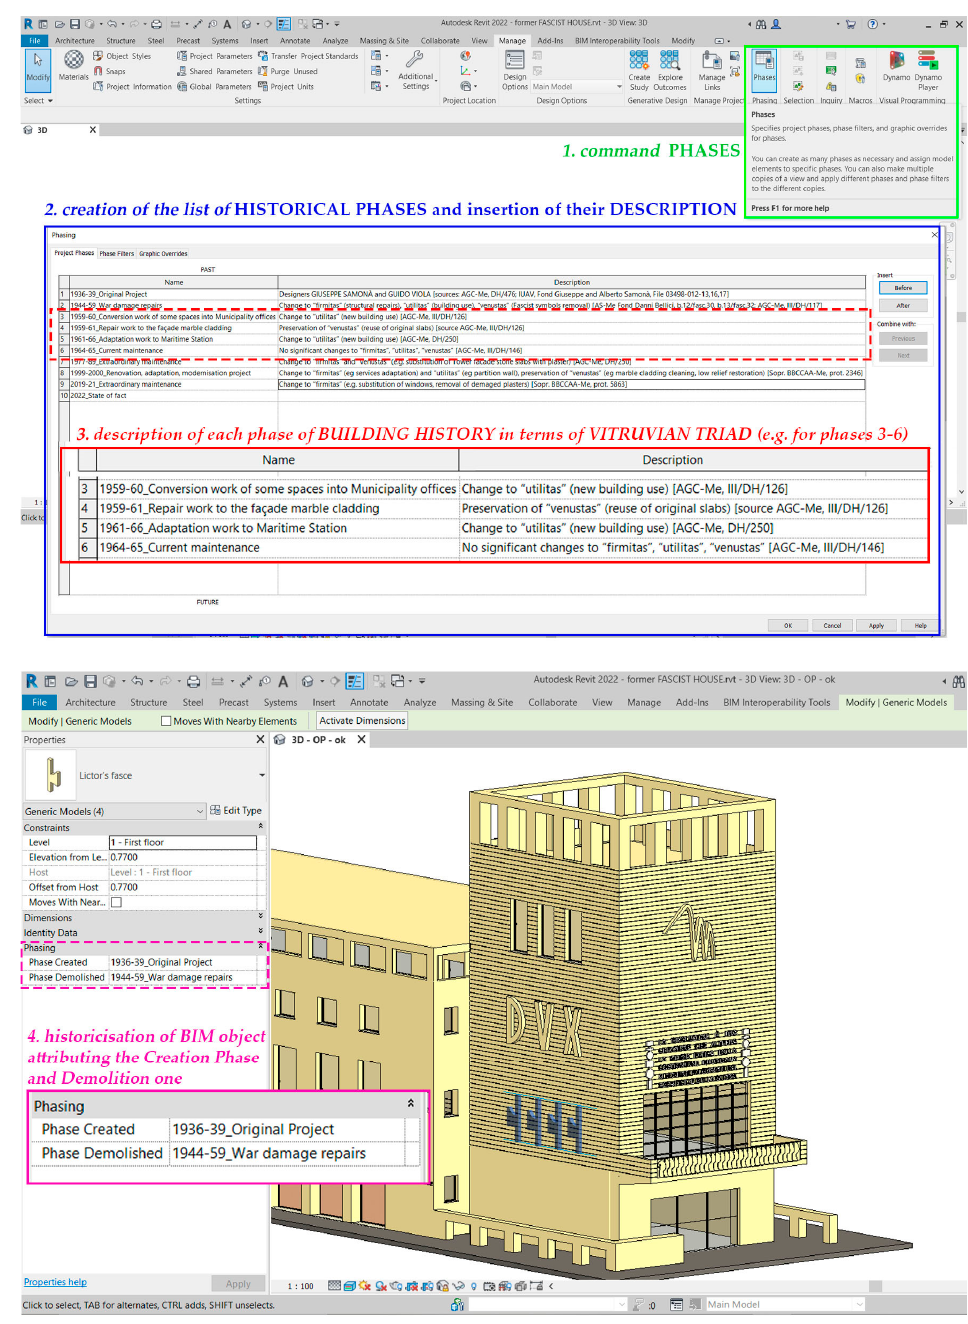
Figure 14. The model historicisation through the parameterisation of the main phases of the former Fascist House history and their attribution to digital objects to document the creation and demolition of real ones.